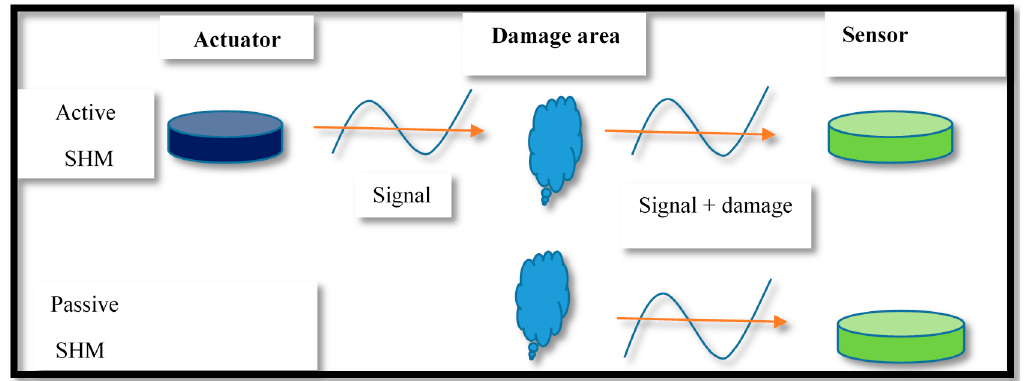
Figure 1. Active and passive SHM methods.